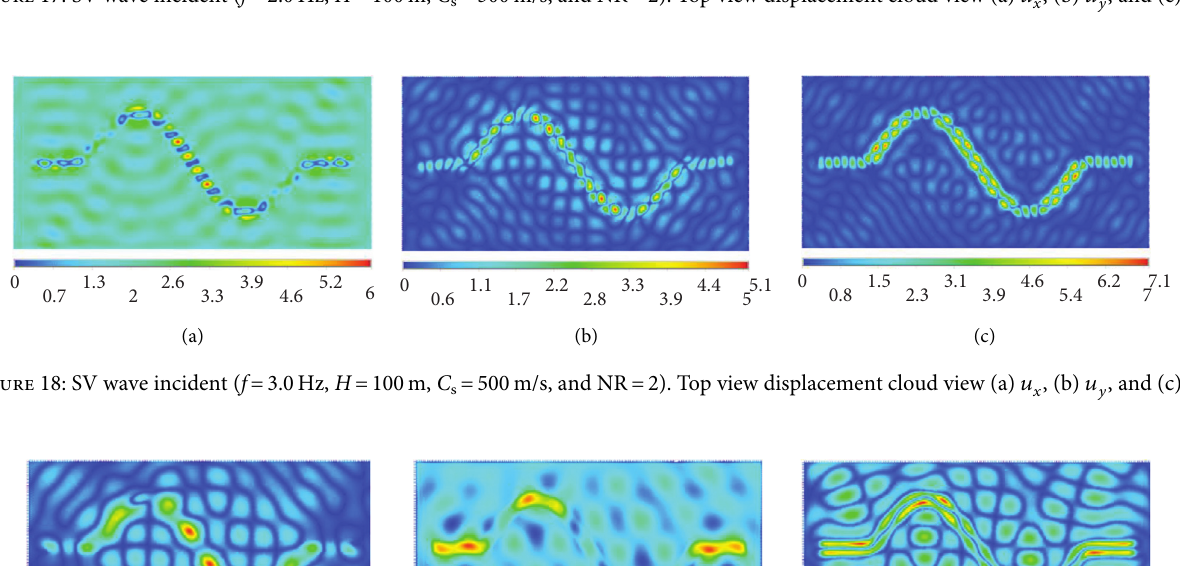
u u x , (b) y , and (c) z .